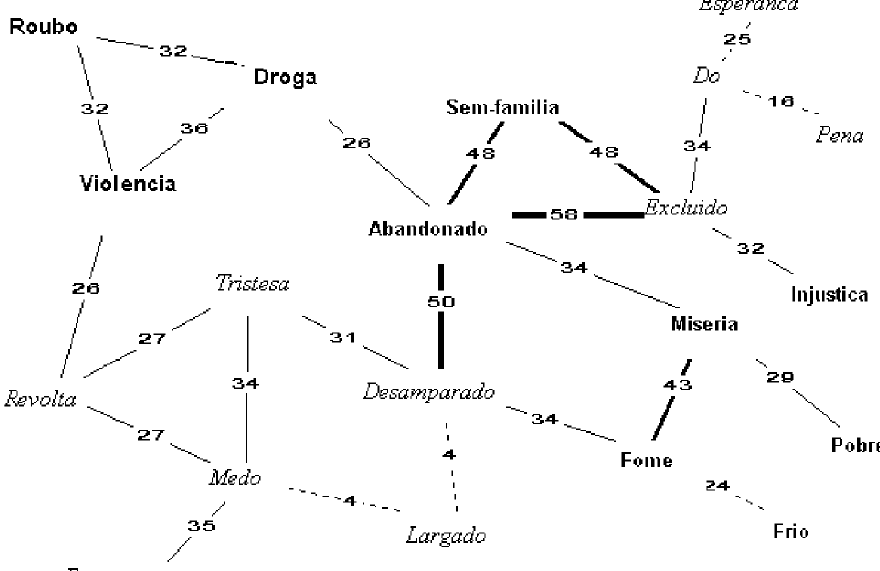
Figura 1. Organiza(cid:231)ªo dos elementos da representa(cid:231)ªo social de (cid:147)meninos de rua(cid:148), selecionados a partir de lista